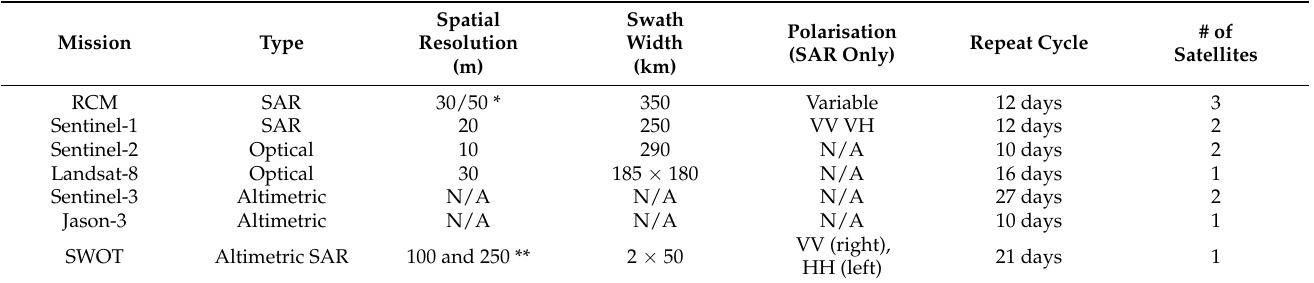
Table 1. Summary of the various SBEO remotely-sensed data used for this study, including their different configurations. Acronyms are defined in